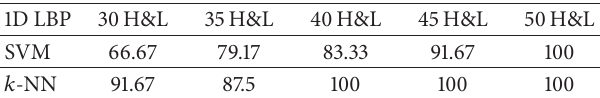
Table 6: The performance of classifiers for the FSVL model when the 1D LBP scheme is used for feature extraction.